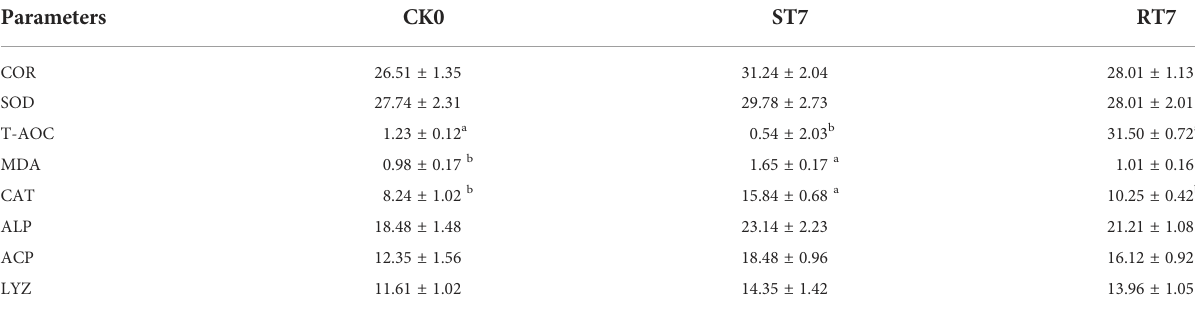
TABLE 2 Effect of starvation and refeeding on non-speci fi c immunity and oxidative stress parameters in golden pompano. Parameters